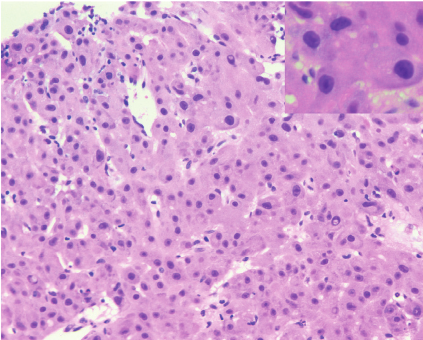
Figure 3: H&E 10 × section shows well to moderately differentiated HCC with trabecular pattern. The inset (H&E 20 × ) shows large pleomorphic nuclei with nucleoli (histopathology of forehead